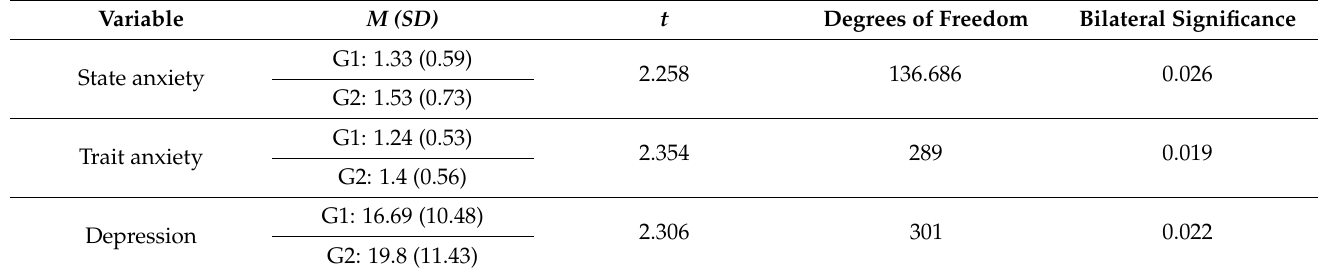
Table 7. Comparisons in anxiety and depression